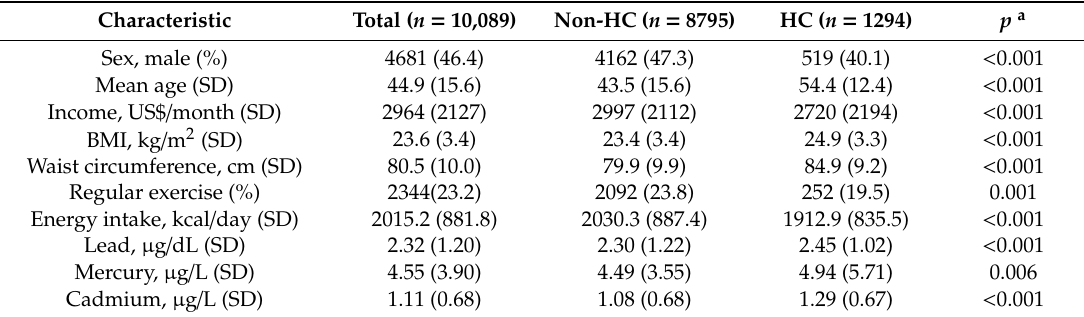
Table 1. Demographic characteristics by categories of hypercholesterolemia